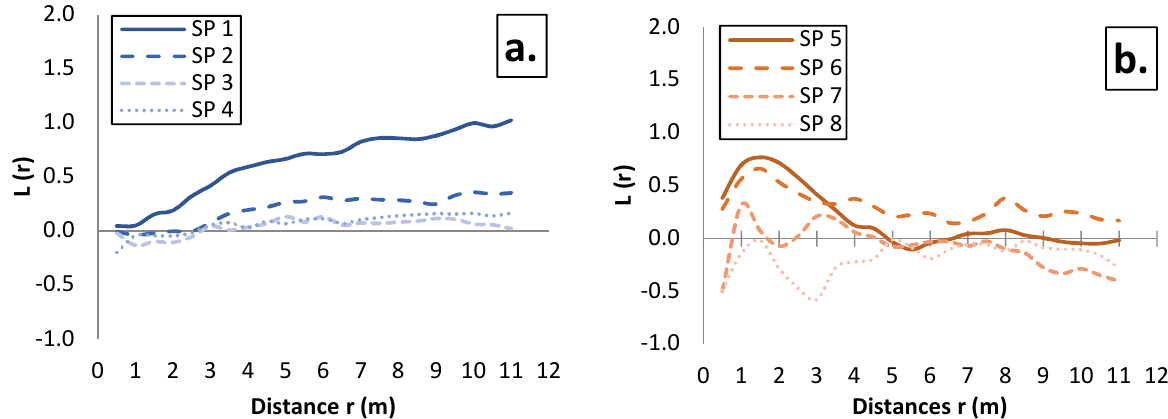
Figure 2. Ripley’s L ( r ) function of the spatial pattern of tree locations in the Serbian spruce ( a ) and Macedonian pine ( b ) forest communities. The values of the function higher than expected (positive values) show a tendency towards clumping, values lower than expected (negative values) show a tendency towards a regular distribution at the observed distance. For simplicity’s sake, lines that indicate a 99% confidence interval based on 199 Monte Carlo simulations of the null hypothesis of complete spatial randomness were not interpreted in this figure.